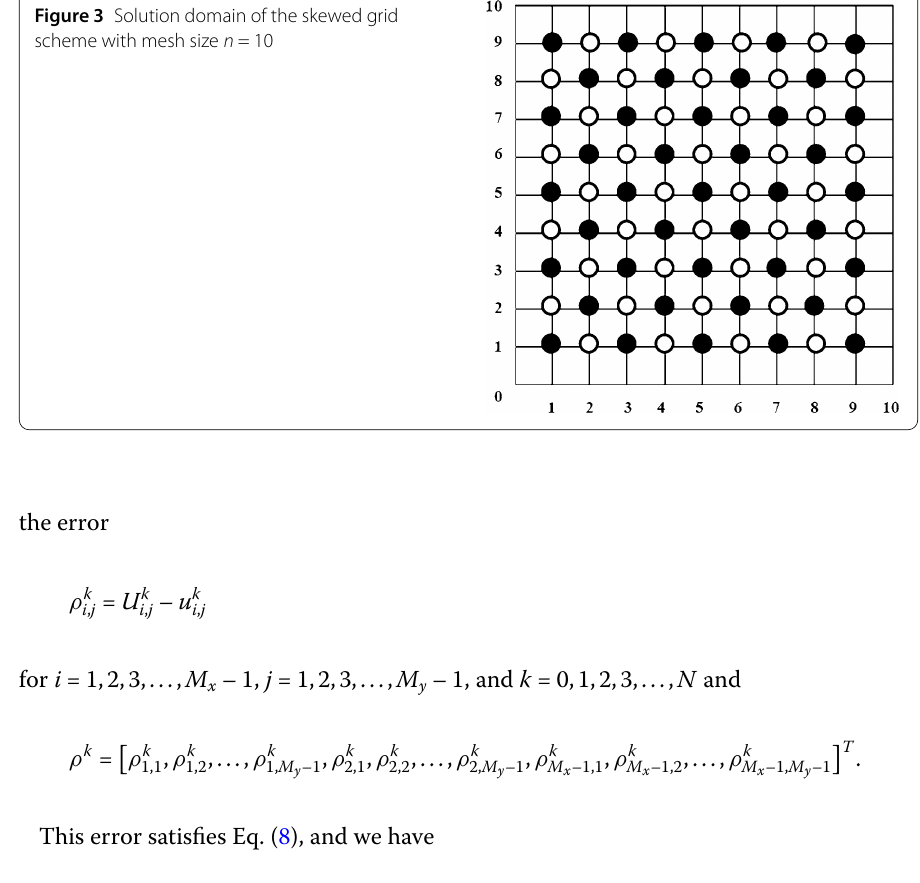
Figure 3 Solution domain of the skewed grid scheme with mesh size n = 10